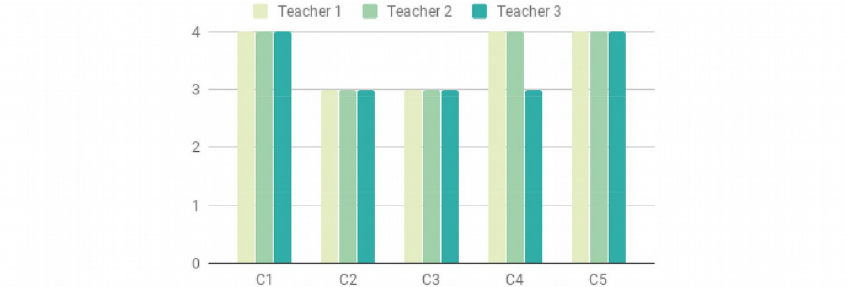
Figure 4. Quantitative results from the questionnaire answered by the teachers. Table 3 shows the coding of the five categories